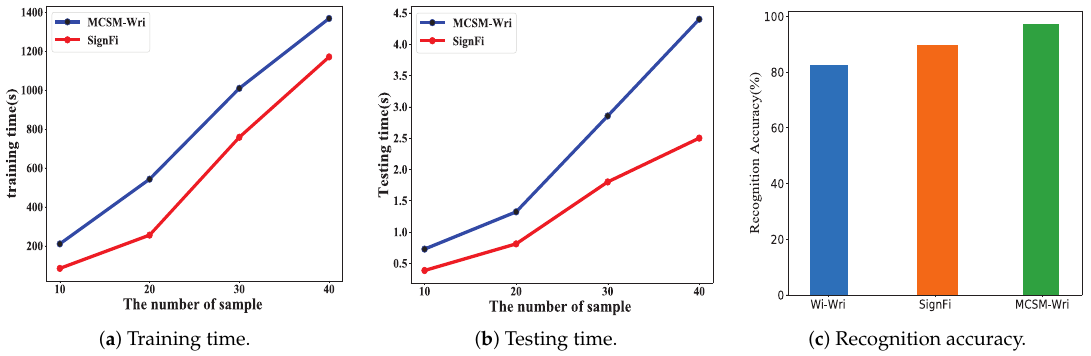
Figure 14. Comparison of the training time, testing time, and accuracy of existing